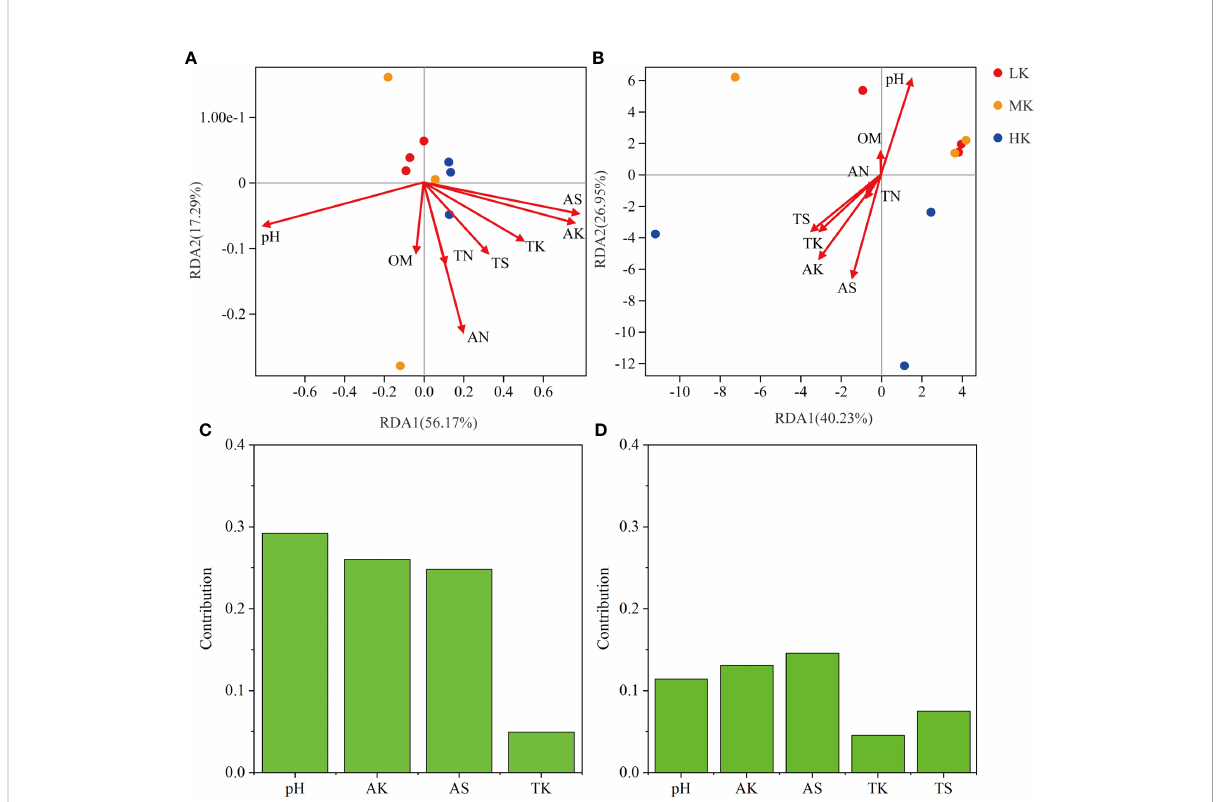
FIGURE 8 RDA analysis among soil samples based on all OTUs (A) and pathways_L3 (B) , and VPA analysis of the effects of soil physicochemical properties on OTUs (C) and pathways_L3 (D) . LK, Low amount of K 2 SO 4 ; MK, Middle amount of K 2 SO 4 ; HK, High amount of K 2 SO 4 . OM, organic matter; TN, total nitrogen; TK, total potassium; TS, total sulfur; AN, available nitrogen; AK, available potassium; AS, available sulfur.